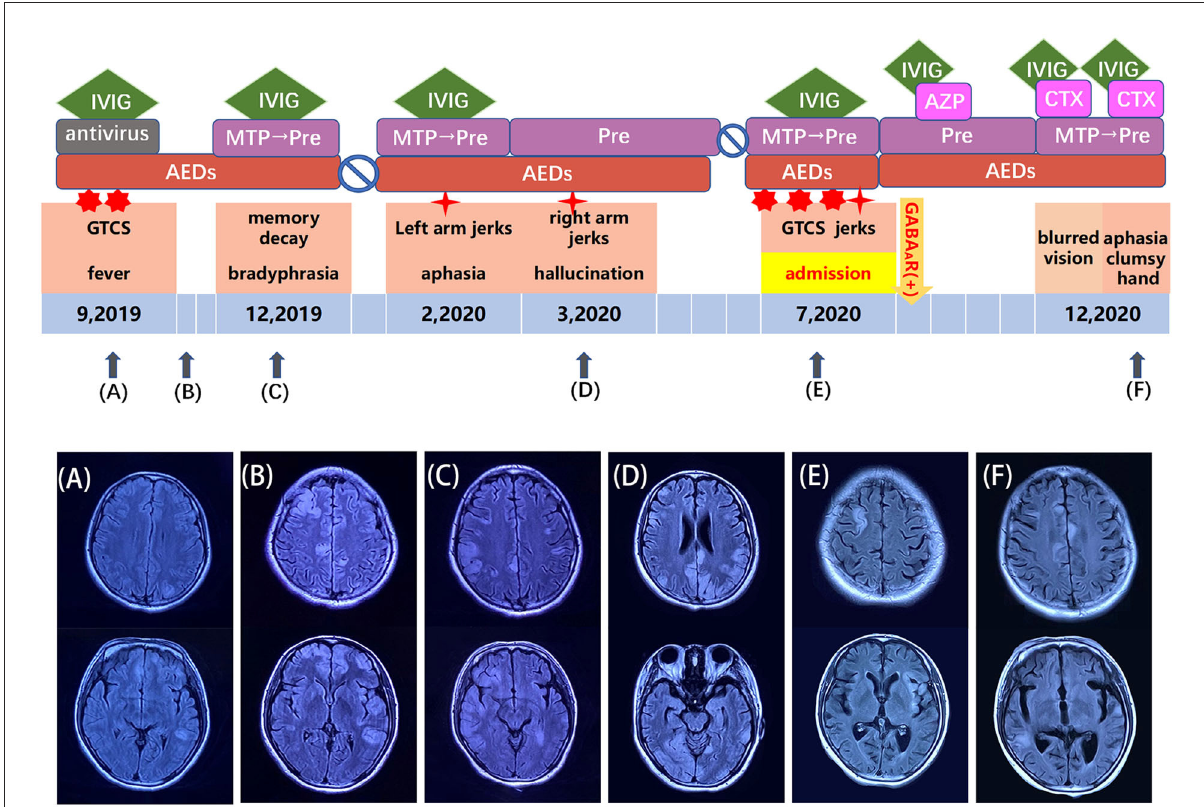
FIGURE1 Schema for the disease course, treatments, and MRI manifestations of anti-GABA A R encephalitis in a 29-year-old woman. (A–F) Clinical manifestations and treatment options corresponding to each time point in the course of the disease. AEDs, anti-epilepsy drugs; AZP, azathioprine; CTX, cyclophosphamide; IVIG, intravenous immunoglobin; MTP,